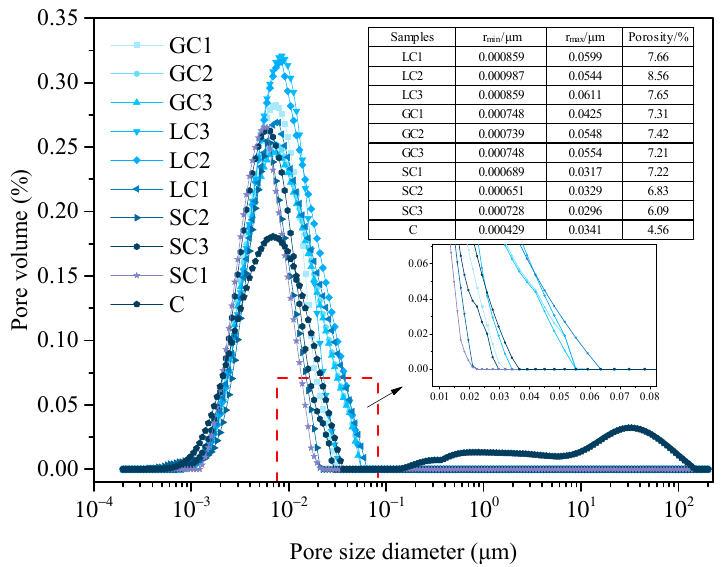
Figure 9. Pore size distribution of ITZ.